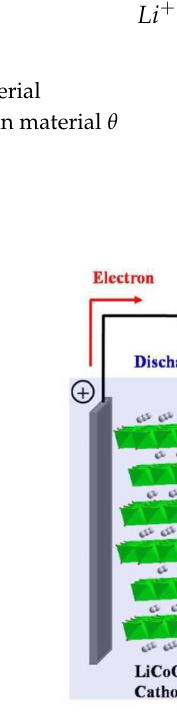
Figure 3. Schematic illustration of the charge/discharge process in a lithium-ion battery, reproduced from